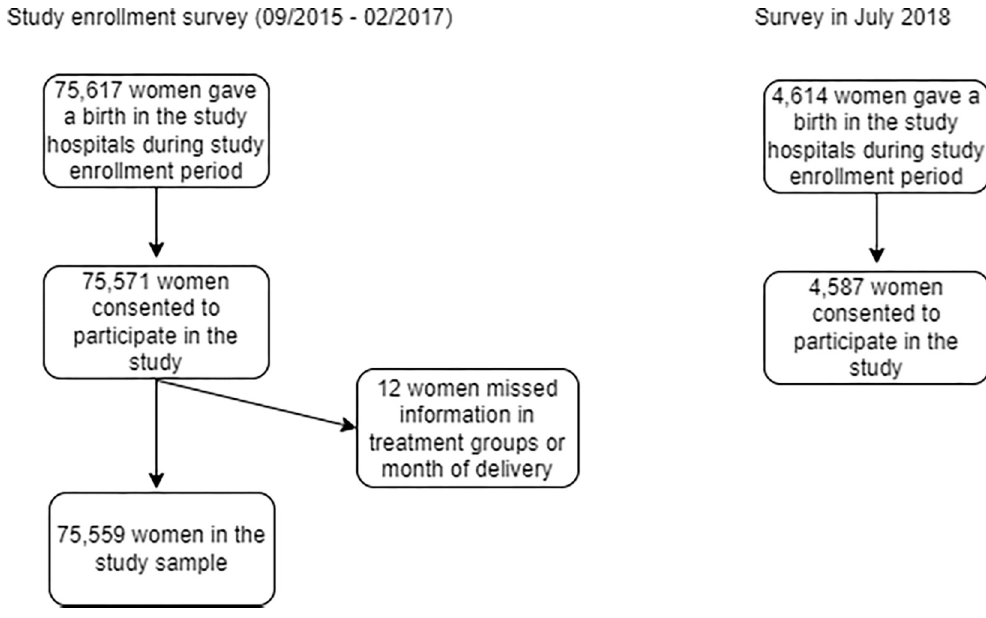
Fig 1. CONSORT flow